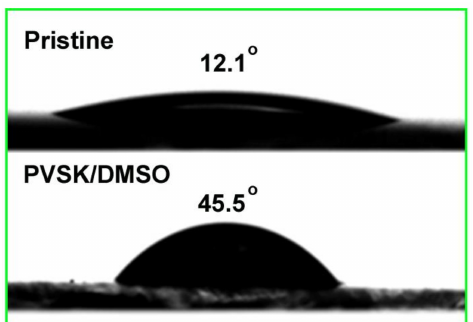
Figure 3. Contact angles with deionized (DI) water drops on the different substrate a pristine PEDOT:PSS film (12.1 o ) and PEDOT:PSS films treated with perovskite layer rinsed away with DMSO (45.5 o ) (PVSK/DMSO).